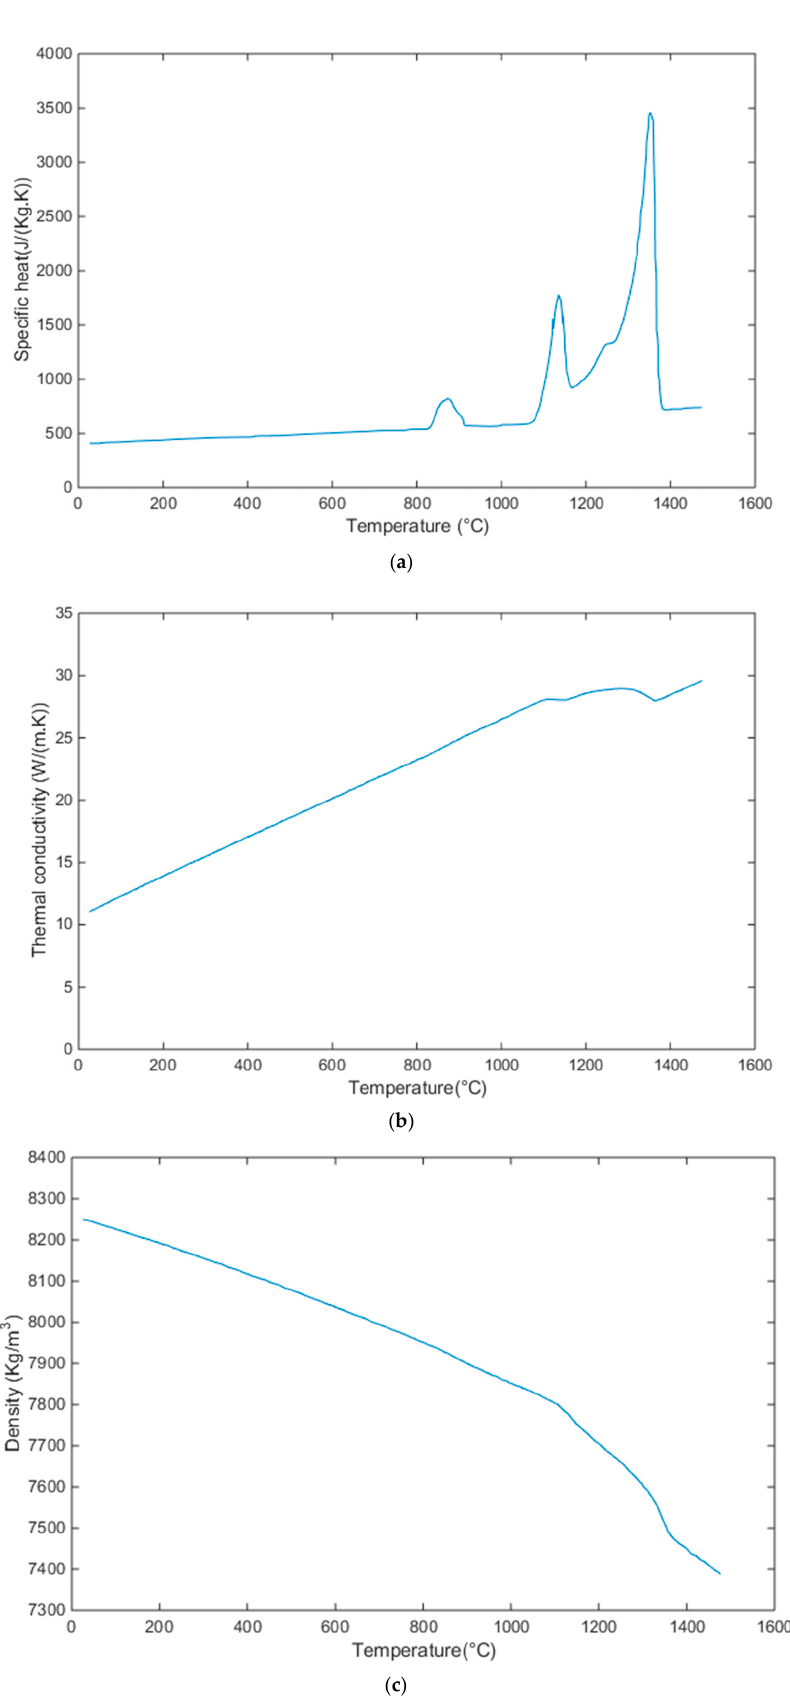
Figure 2. Thermophysical properties for In718 [27]. ( a ) Specific heat, ( b ) thermal conductivity, ( c )